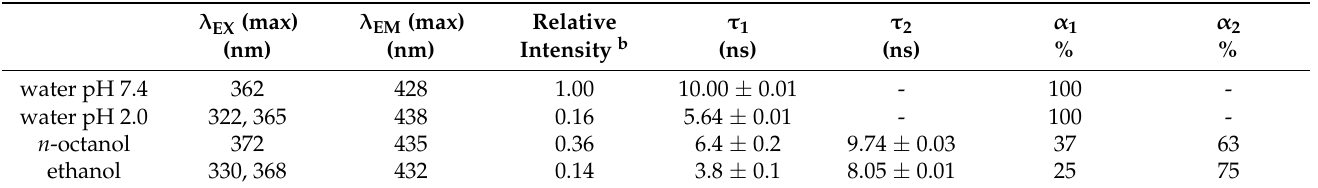
Table 2. Fluorescence parameters of FAVI determined in various solvents: λ (max) of the excitation and emission spectra, relative fluorescence intensities, lifetimes ( τ ) and relative amplitudes ( α ) of the lifetime components determined by TCSPC a [t = 25 ◦